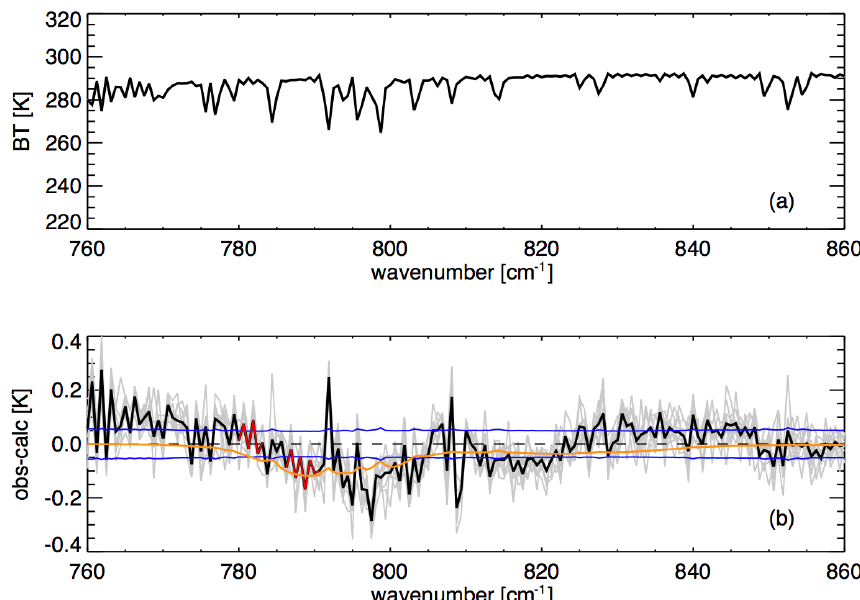
Figure 4. (a) Measured CrIS brightness temperature spectrum for a case co-located with an ATom-1 profile on 17 August 2016 at 36.2 ◦ lati- tude, − 27 . 3 ◦ longitude. (b) Residual spectra (observed – calculated) for match-ups with this ATom-1 case, with zero PAN in the calculation, after retrieval of surface and atmospheric temperature, water vapor, cloud optical depth, cloud-top pressure and surface emissivity. Gray lines show residuals for individual CrIS FOVs that meet the coincidence criteria. The black line shows the mean residual for this set. Red segments show the microwindows used in the retrievals. Blue lines show the CrIS instrument noise (noise equivalent delta brightness temperature, or NEdT) for a single CrIS FOV. Orange line shows the shape of the PAN spectral feature.